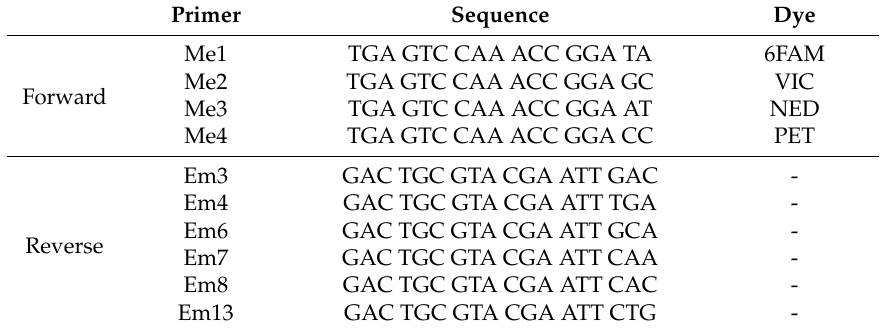
Table 2. List of sequence-related amplified polymorphism (SRAP) primers used in the